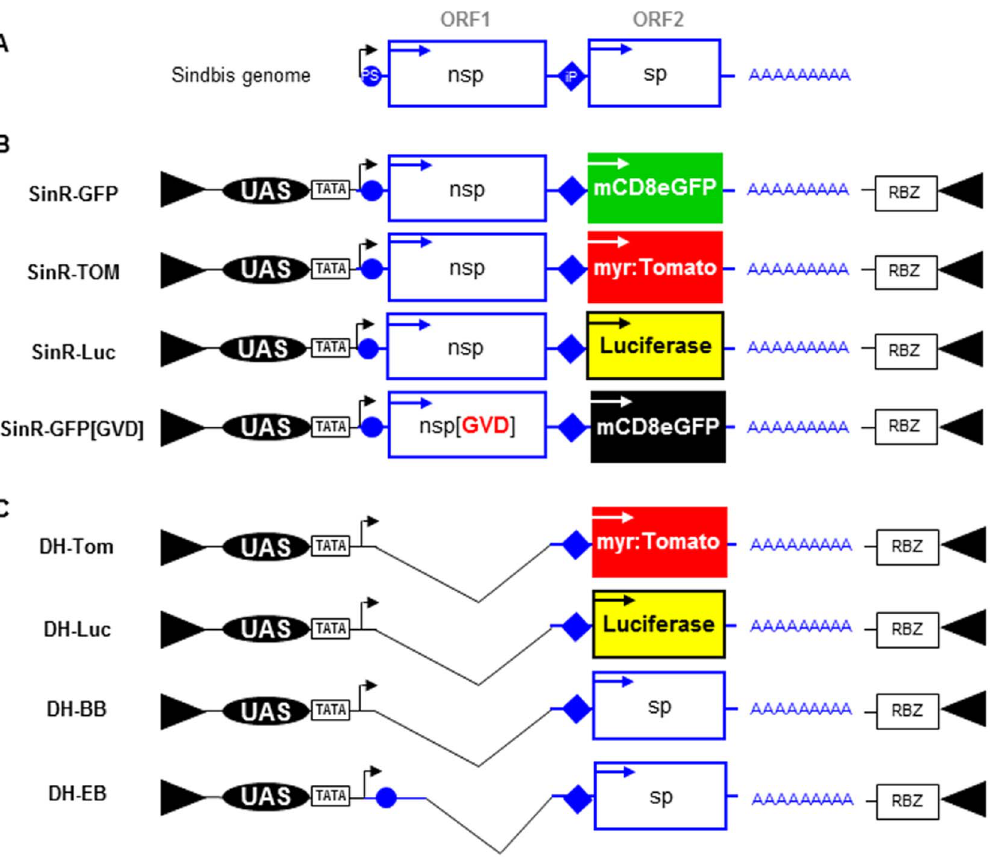
Figure 1. A toolkit of transgenic Sindbis replicons. A. Schematic of Sindbis genome, a bicistronic single-stranded RNA with positive polarity: the 5 9 end contains a ‘packaging signal’ (PS) for incorporation into the particle. An ‘internal Promoter’ (iP) can be found (on the ‘antigenome’; see Figure S1A) in between the viral ORF’s. Abbreviations: nsp = ‘non-structural proteins’; sp = ‘structural proteins’. B. Four transgenic fly strains containing different Sindbis replicons (SinR) stably inserted into the genome. Each transgenic replicon is harboring different reporter genes, or mutations. Abbreviations: UAS = GAL4 ‘GAL4 Upstream activating sequence’; TATA = hsp70 TATA box; RBZ: Hepatitis Delta Ribozyme; GFP = membrane tagged mCD8:eGFP fusion protein; TOM = myristoylated Tomato; Luc = firefly luciferase; nsp[GVD] = point-mutated RNA-dependent RNA Polymerase. C. Four replication-incompetent replicons (SinR), all lacking ORF1 due to deletions in the Sindbis genomic DNA sequence, and harboring different sequences in ORF2. Note that DH-EB harbors a smaller deletion, thus retaining a ‘packaging signal’.